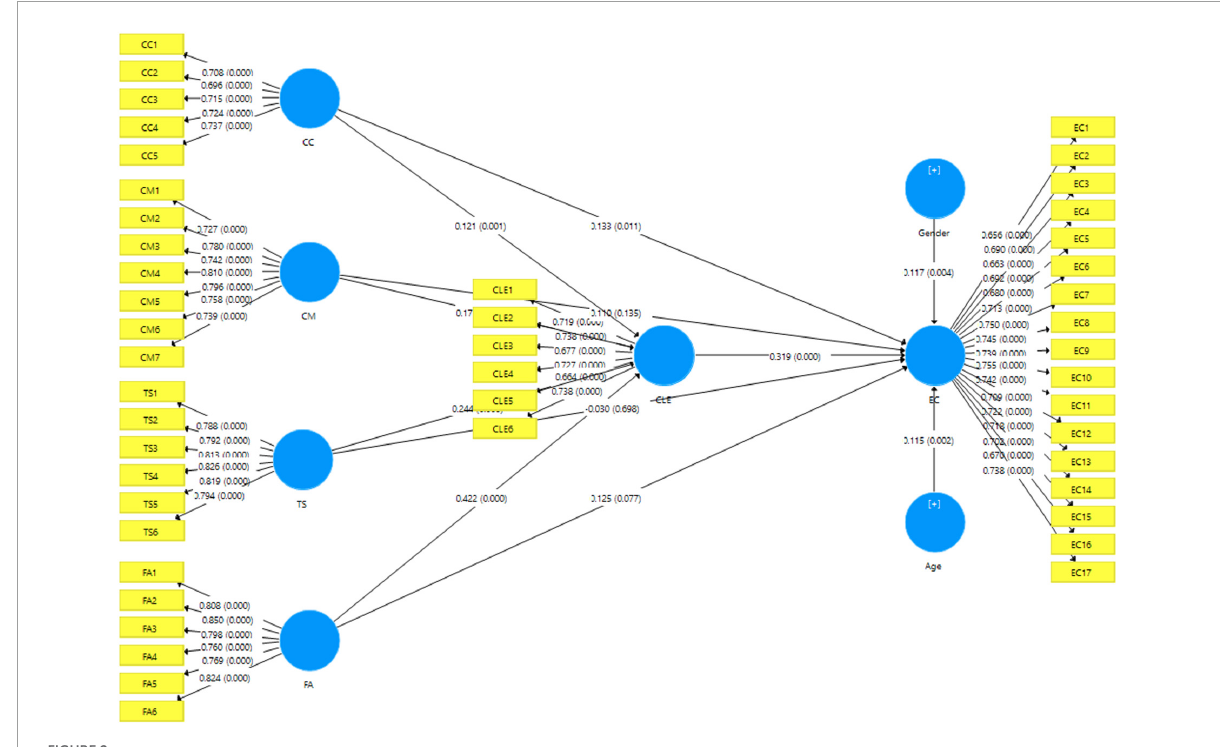
FIGURE2 Structural relations between constructs.